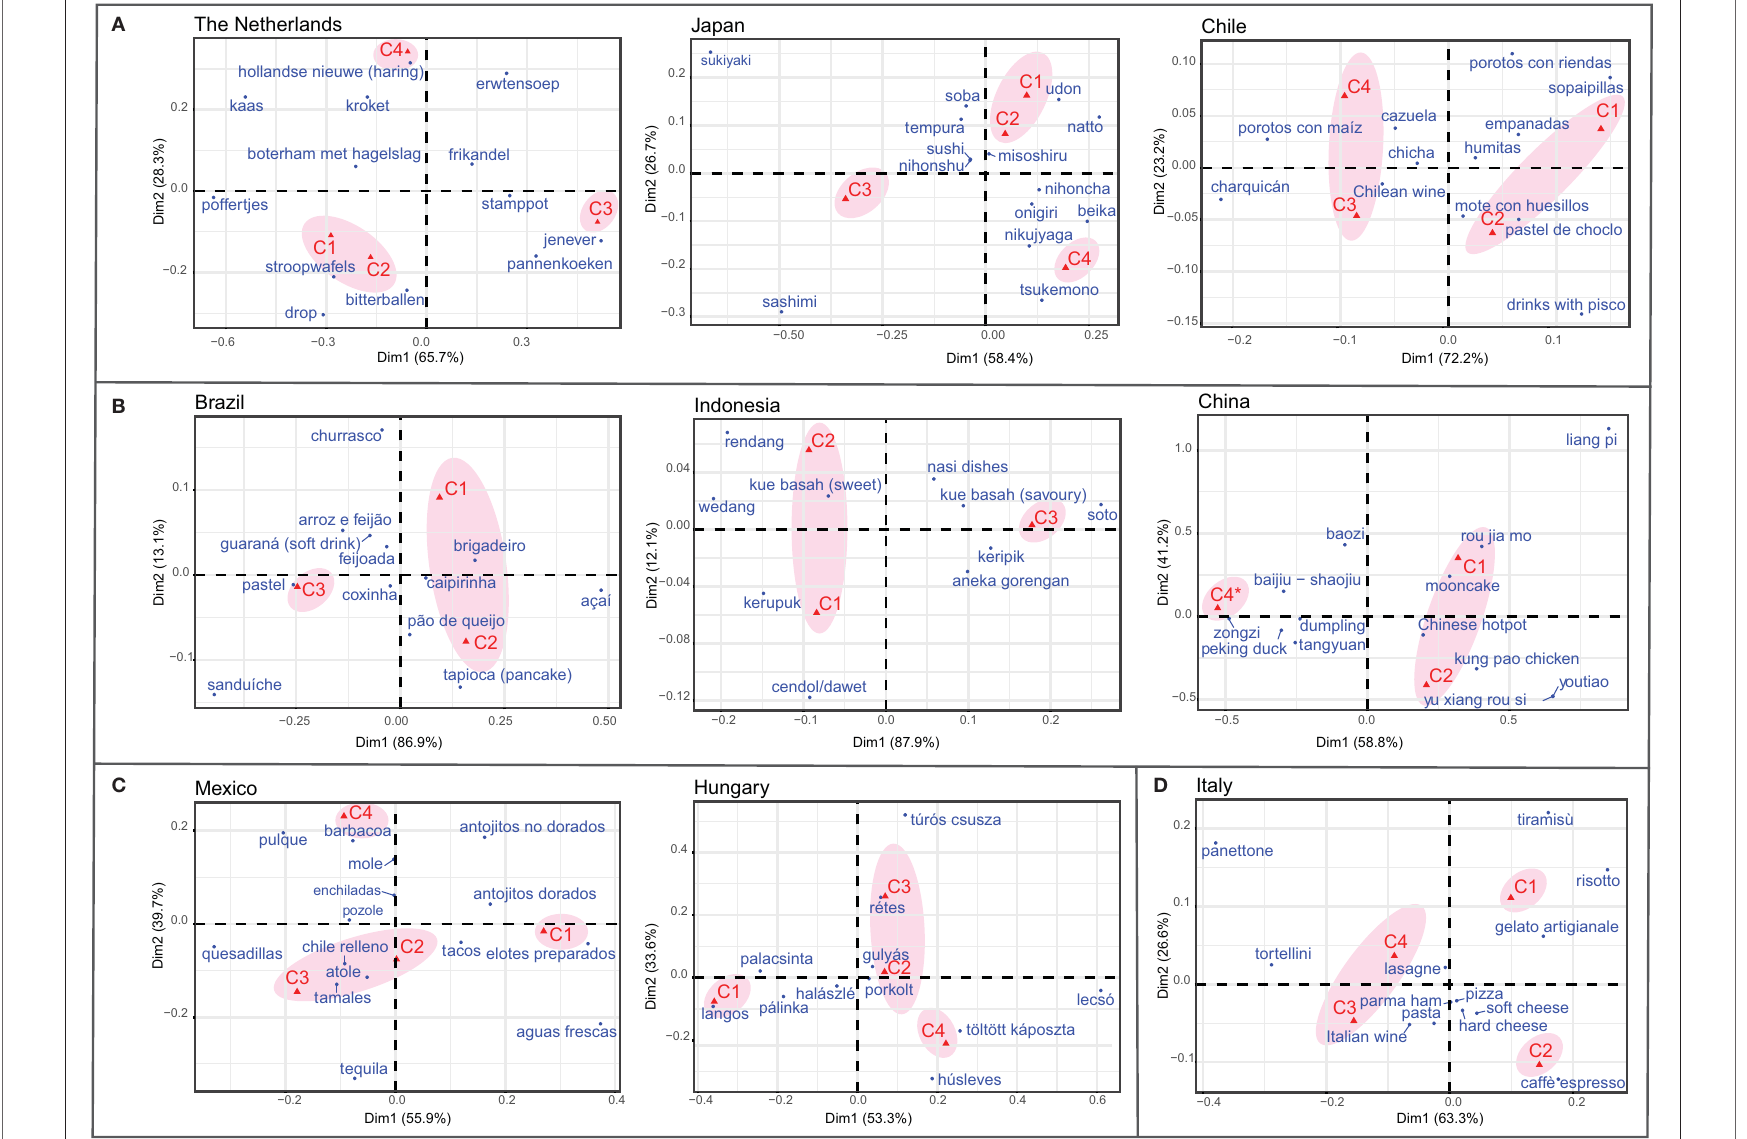
FIGURE 2 | Perceptual maps of the correspondence analyses representing the relationships between the traditional foods and beverages mentioned and the different age cohorts by country. (A) groups the countries where age cohorts C1 and C2 were clustered together; (B) groups the countries where age cohorts C1–C3 or C1-C2-C4* (China) were analysed and C1 and C2 were clustered together; (C) groups countries where middle-age cohorts C2 and C3 were clustered together; and (D) shows the Italian clusters where oldest age cohorts C3 and C4 were in the same cluster. C1 = 18–29 years of age, C2 = 30–39 years of age, C3 = 40–49 years of age, C4 = 50 + years of age; and C4* = 40 + years of age. Clusters ovals were added to the perceptual maps using adobe illustrator to aid with the